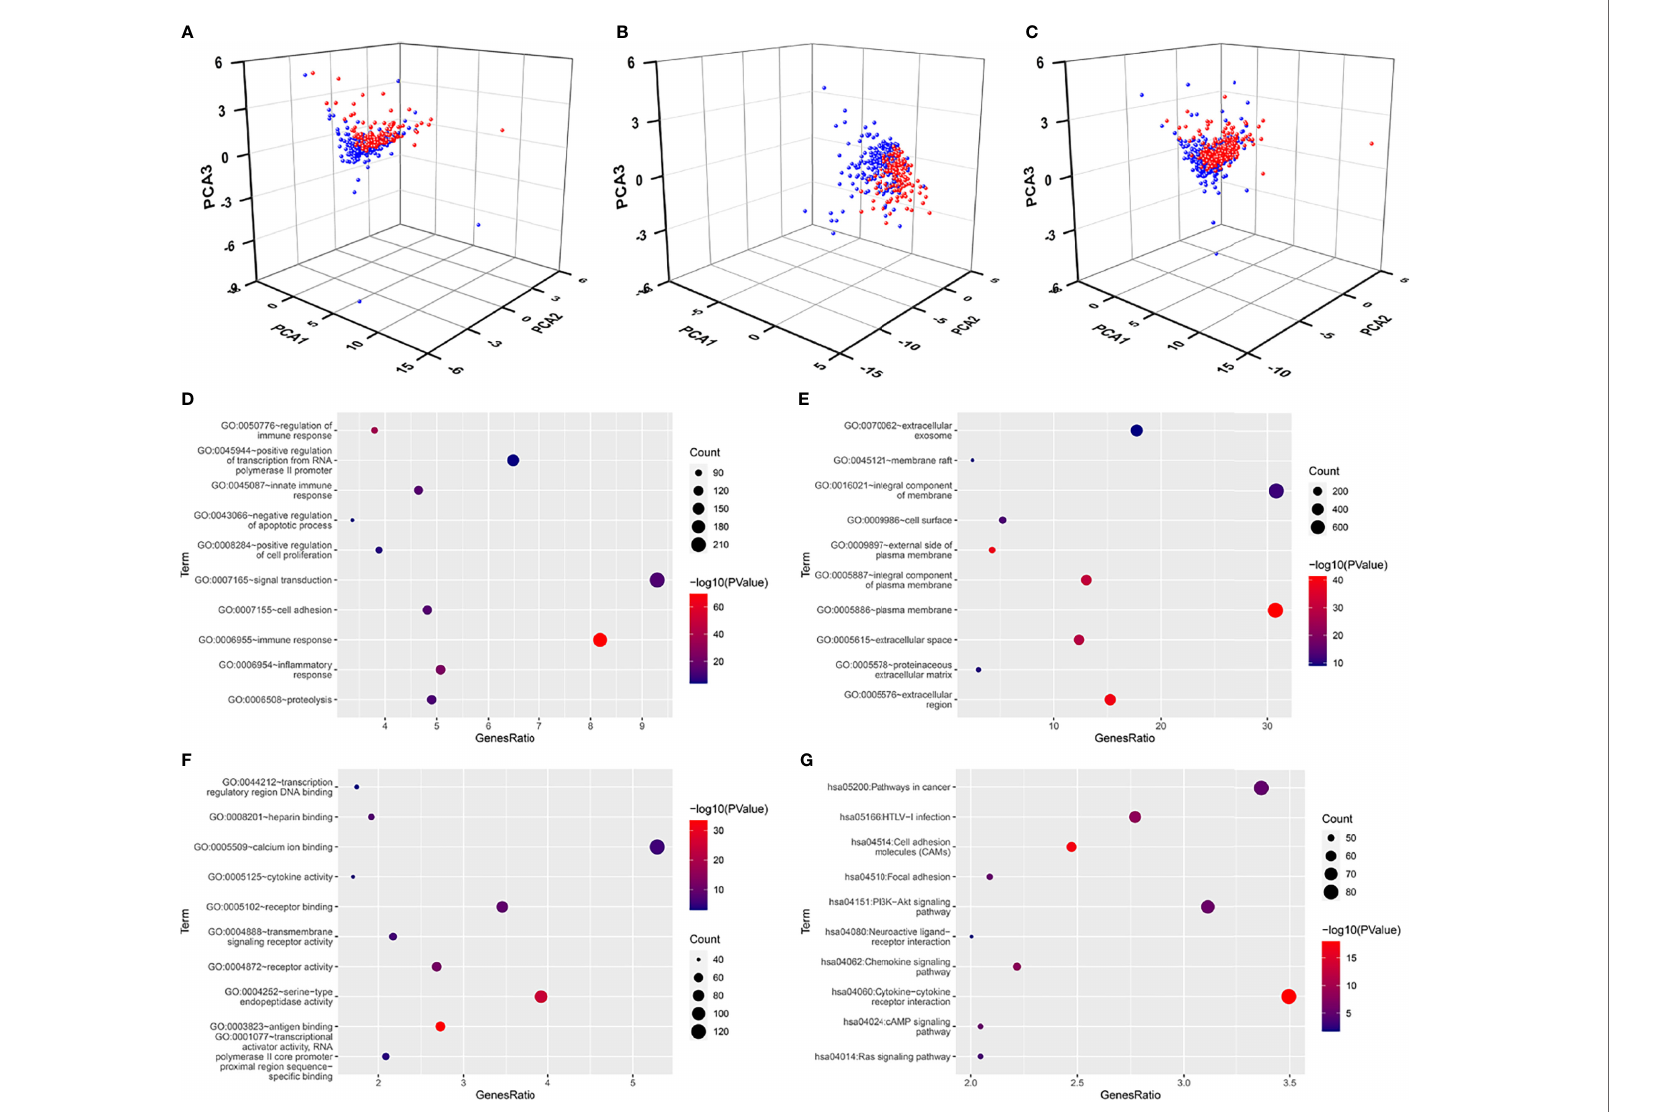
FIGURE 5 | Principal component analyses and enrichment analyses. (A – C) Principal component analyses (PCA) plots depicted distinct distribution of high- and low-risk groups based on these seven FI-DEGs in the training group (A) , validation group (B) , and entire group (C) . Blue means low-risk group. Red means high-risk group. (D – F) Top 10 signi fi cantly enriched GO. (D) For BP. (E) For CC. (F) For MF. (G) Top 10 signi fi cantly enriched